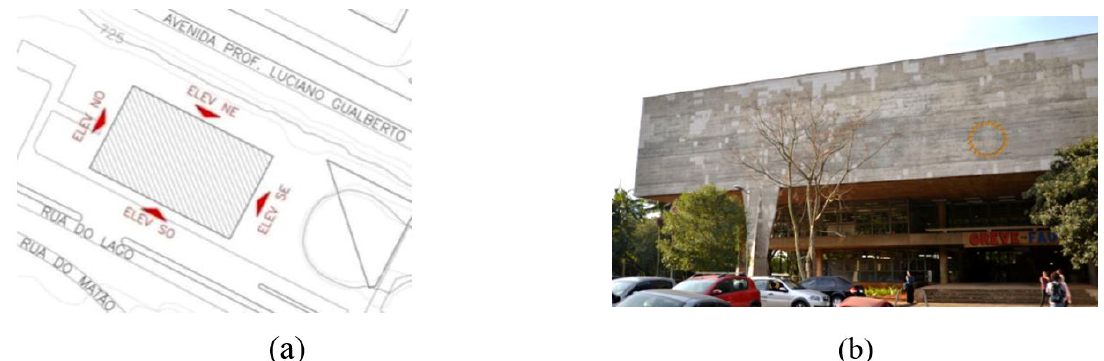
Figure 1. (a) Building placement with direction of Northeast (NE), Southeast (SE), Southwest (SO) and Northwest (NO) façades; (b) and partial view of the main façade (SW). (Photo: Authors’ collection,